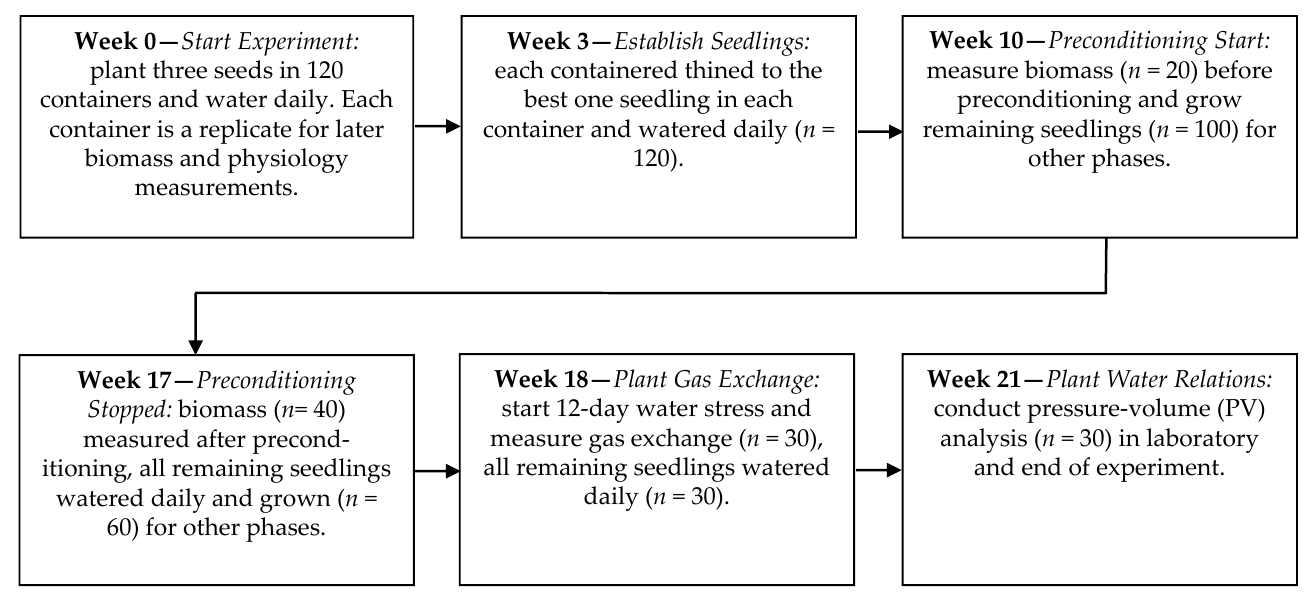
Figure 1. Timeline of experiment with key phases (in italics, e.g., Start Experiment ) and outcomes. Preconditioning was the daily watering or watering of seedlings after exhibiting leaf wilting, and then re-water and continue this during the 7-week preconditioning period. Each biomass measurement (week 10 and week 17) was a destructive harvest for four replications per each of the five seed sources and preconditioning treatments. Gas exchange and plant water relations—each had three replications per each seed source and preconditioning combination. Each replication was in one container.